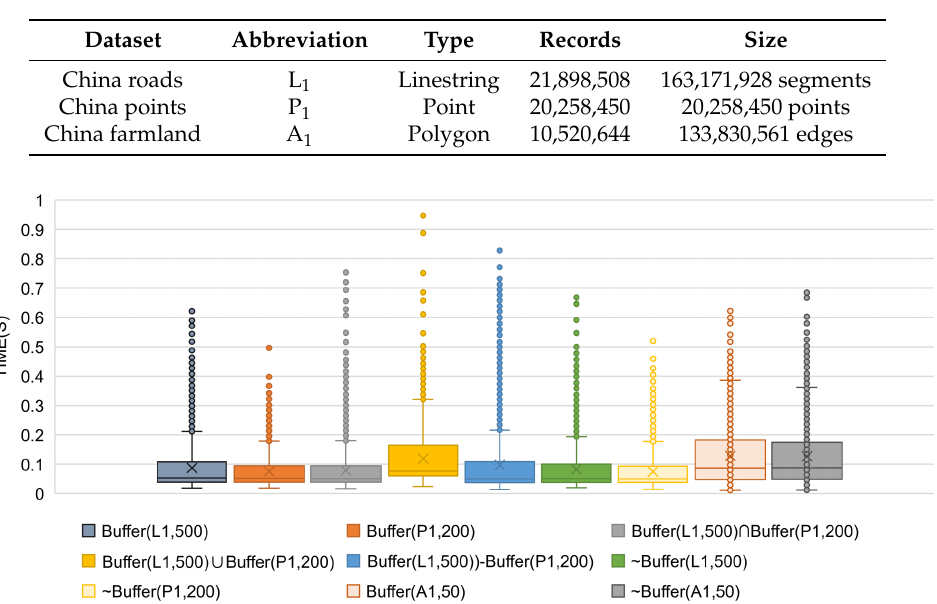
Table 9. Datasets of China.